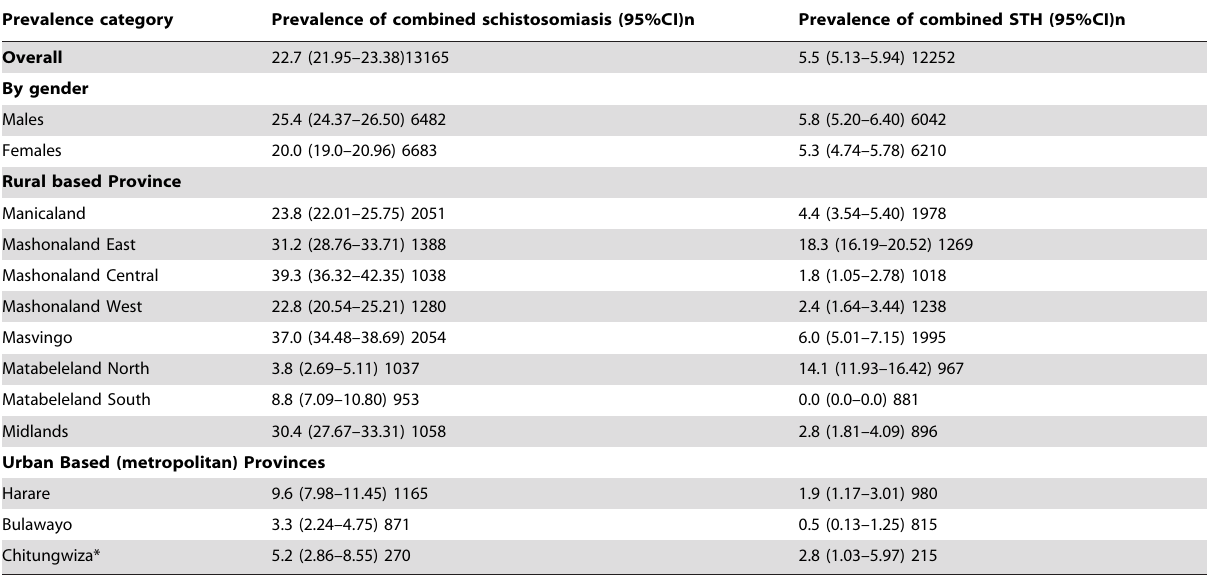
Table 1. Prevalence of combined schistosomiasis and STH infection by province in Zimbabwe in 2011.